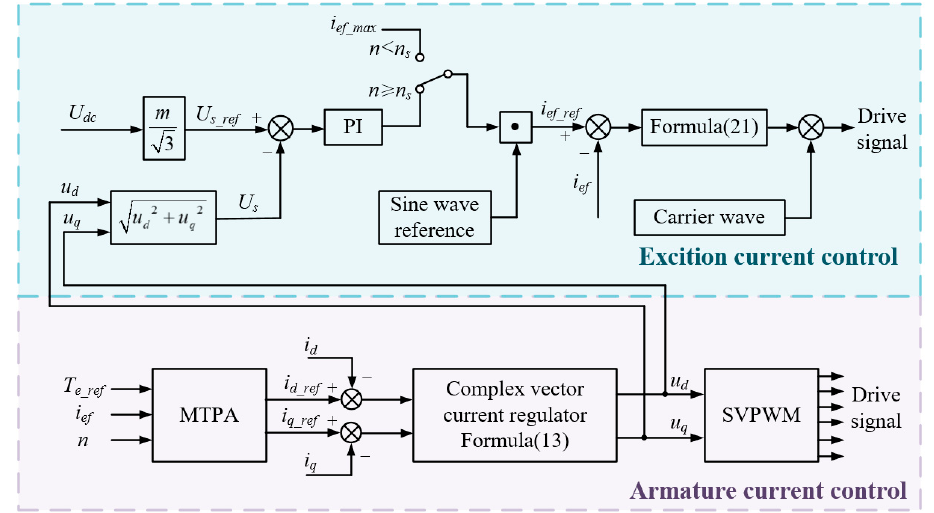
Figure 14. The block diagram of the current control system.